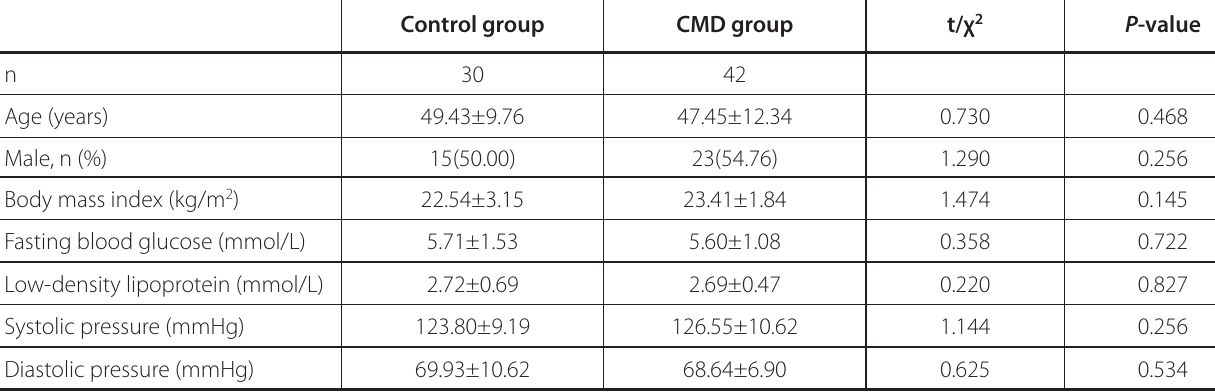
Table 1 . Comparison of baseline data between the groups.